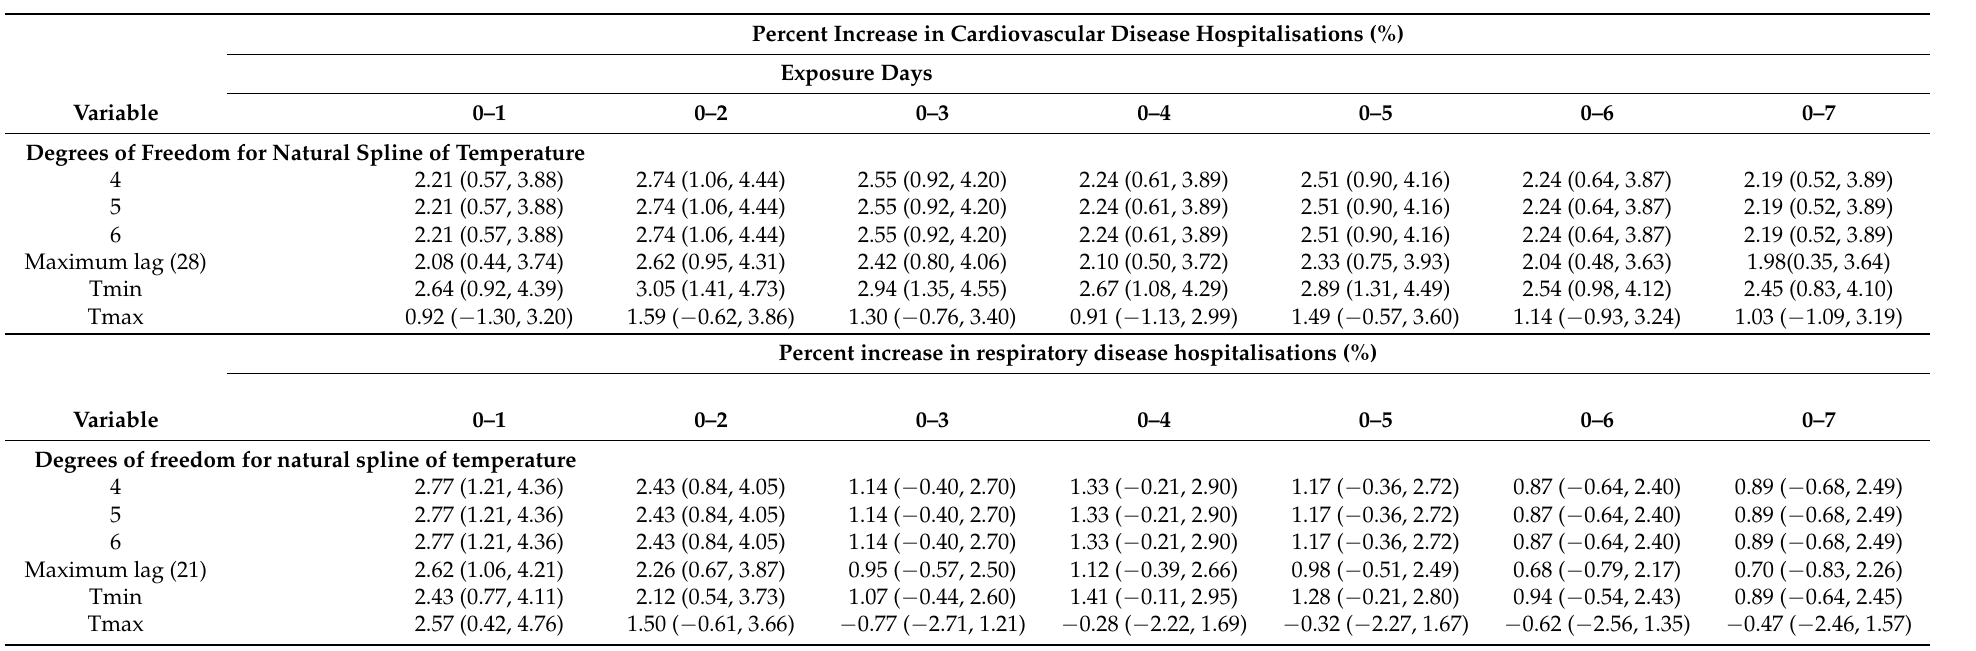
Table A3. Results of sensitivity analyses by changing the model options for the crossbasis function of the daily mean temperature on the association between TV, and cardiovascular and respiratory disease hospital admissions on all exposure days for all ages. The results were scaled per IQR increase in